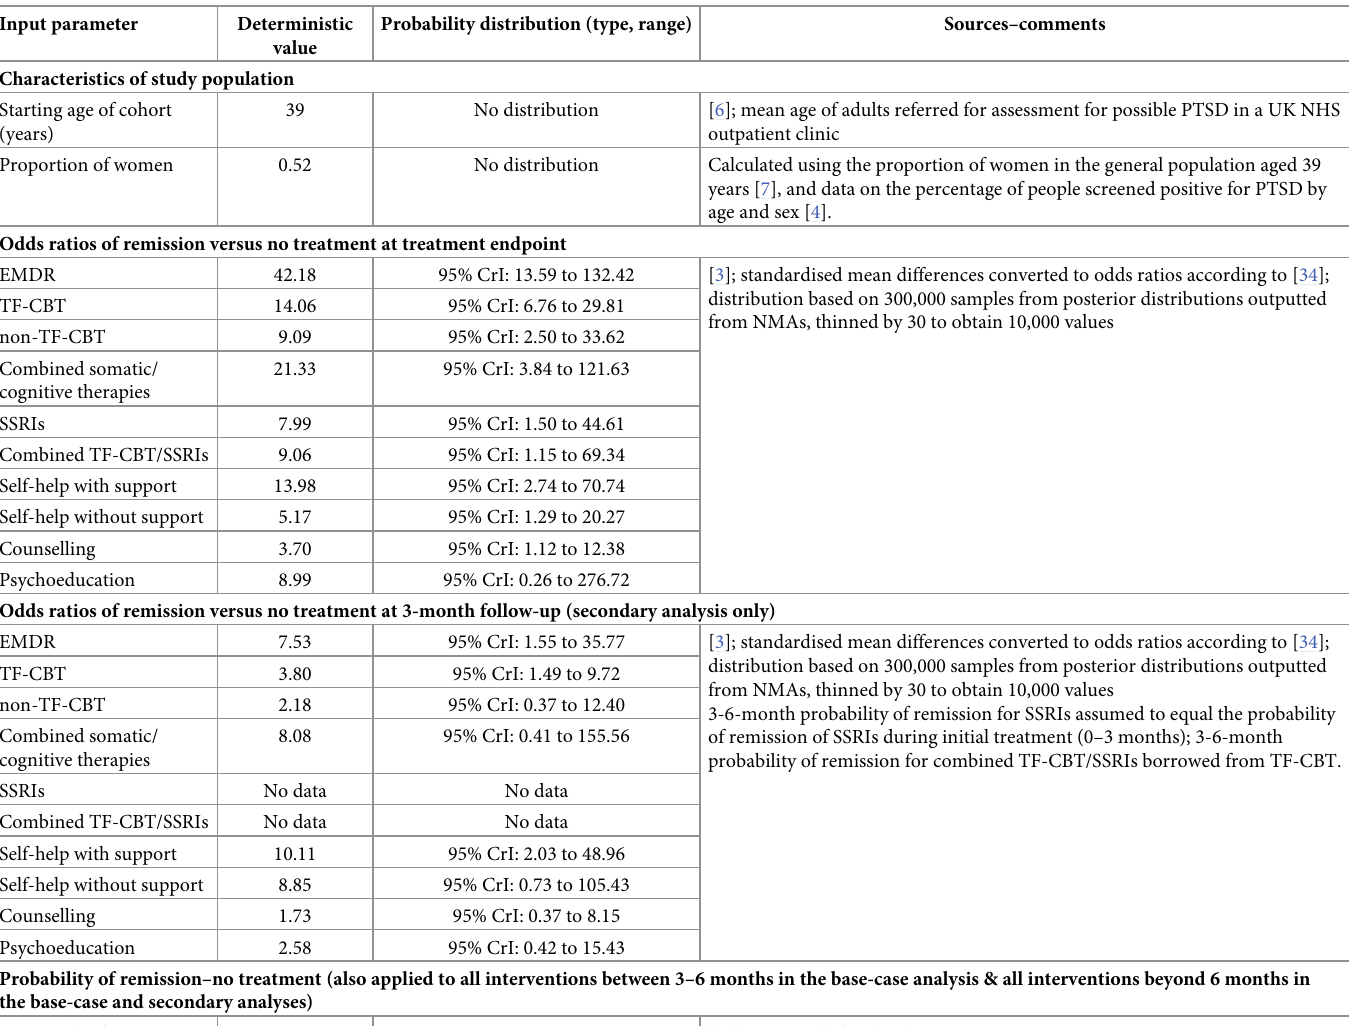
Table 2. Economic model input